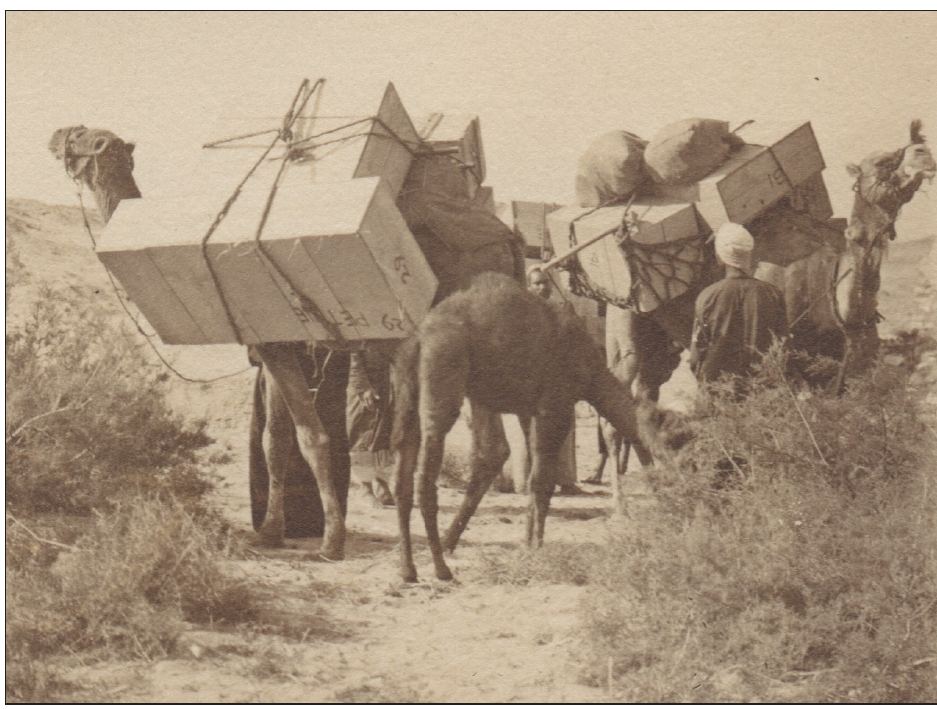
Figure 1: Camels loaded with crates of artefacts from the Petrie-led British School of Archaeology in Egypt excavation at Kafr Ammar 1912 (Photo Petrie Museum of Egyptian Archaeology,